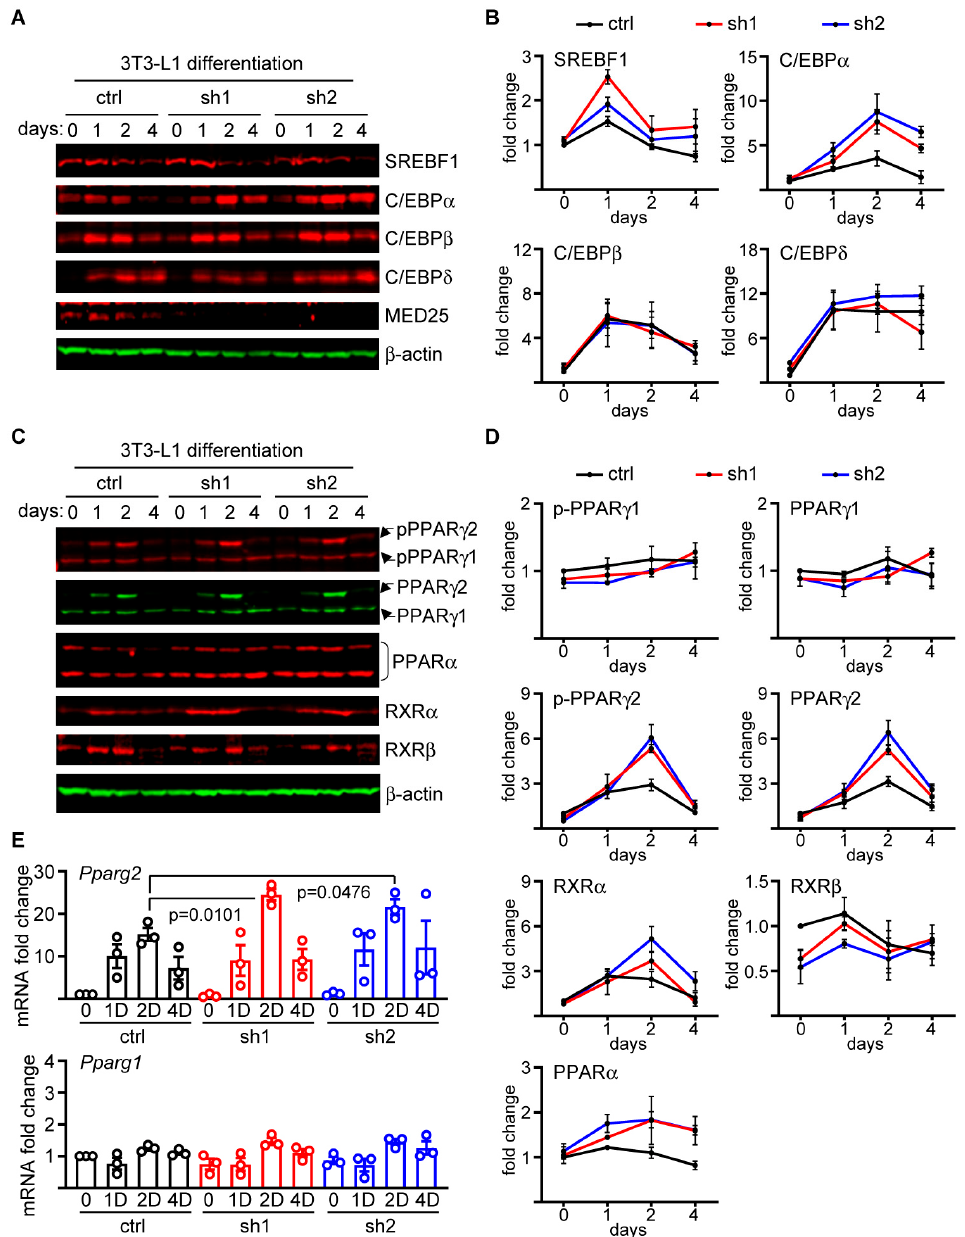
Figure 4. Med25 suppresses the expression of adipogenic master regulators. ( A ) Kinetics of protein expression analyses on control and MED25-depleted 3T3-L1 cells (sh1 and sh2) and differentiated into adipocytes probed for SREBF1, C/EBP α , C/EBP β , C/EBP δ , MED25, and β -actin (loading